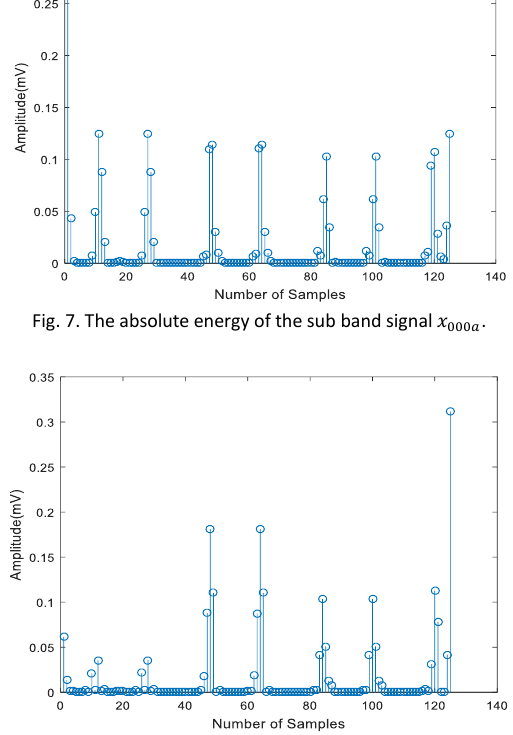
Fig. 8. The absolute energy of the sub band signal 𝑥 000𝑏